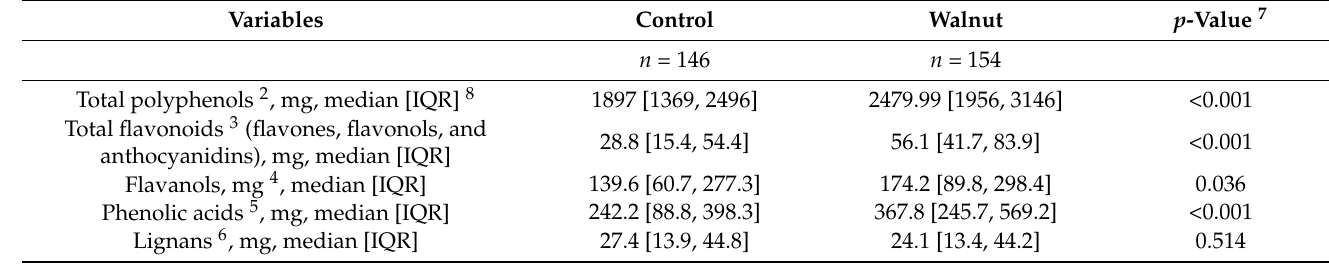
Table 3. Daily intake of energy-adjusted dietary polyphenols 1 by treatment group.